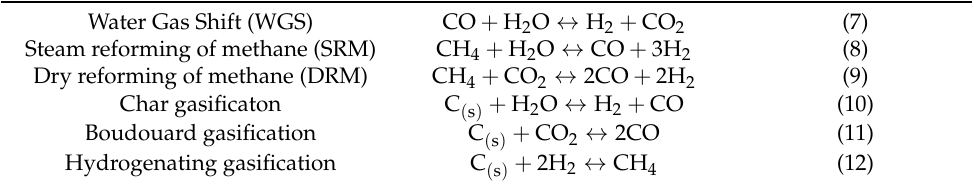
Table 5. Secondary reactions of stem gasification of